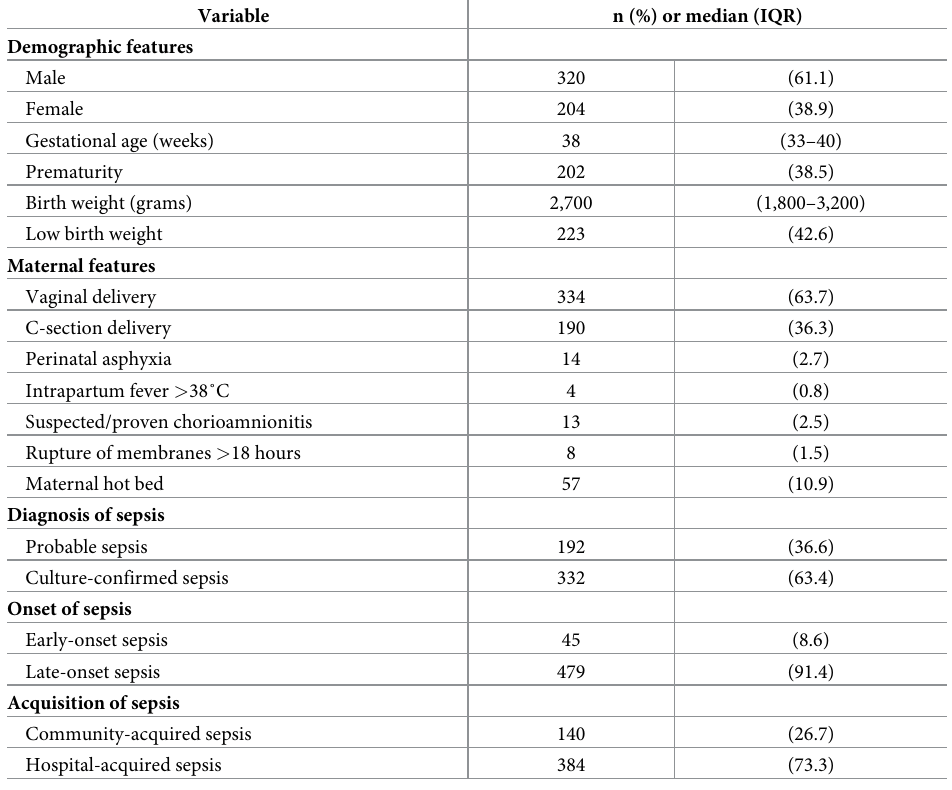
Table 1. Baseline characteristics of 524 patients recruited with neonatal sepsis. Variable n (%) or median